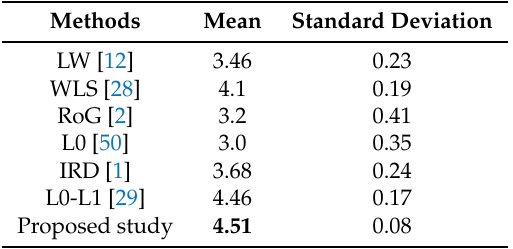
Table 1. Subjective evaluation of the compared methods.